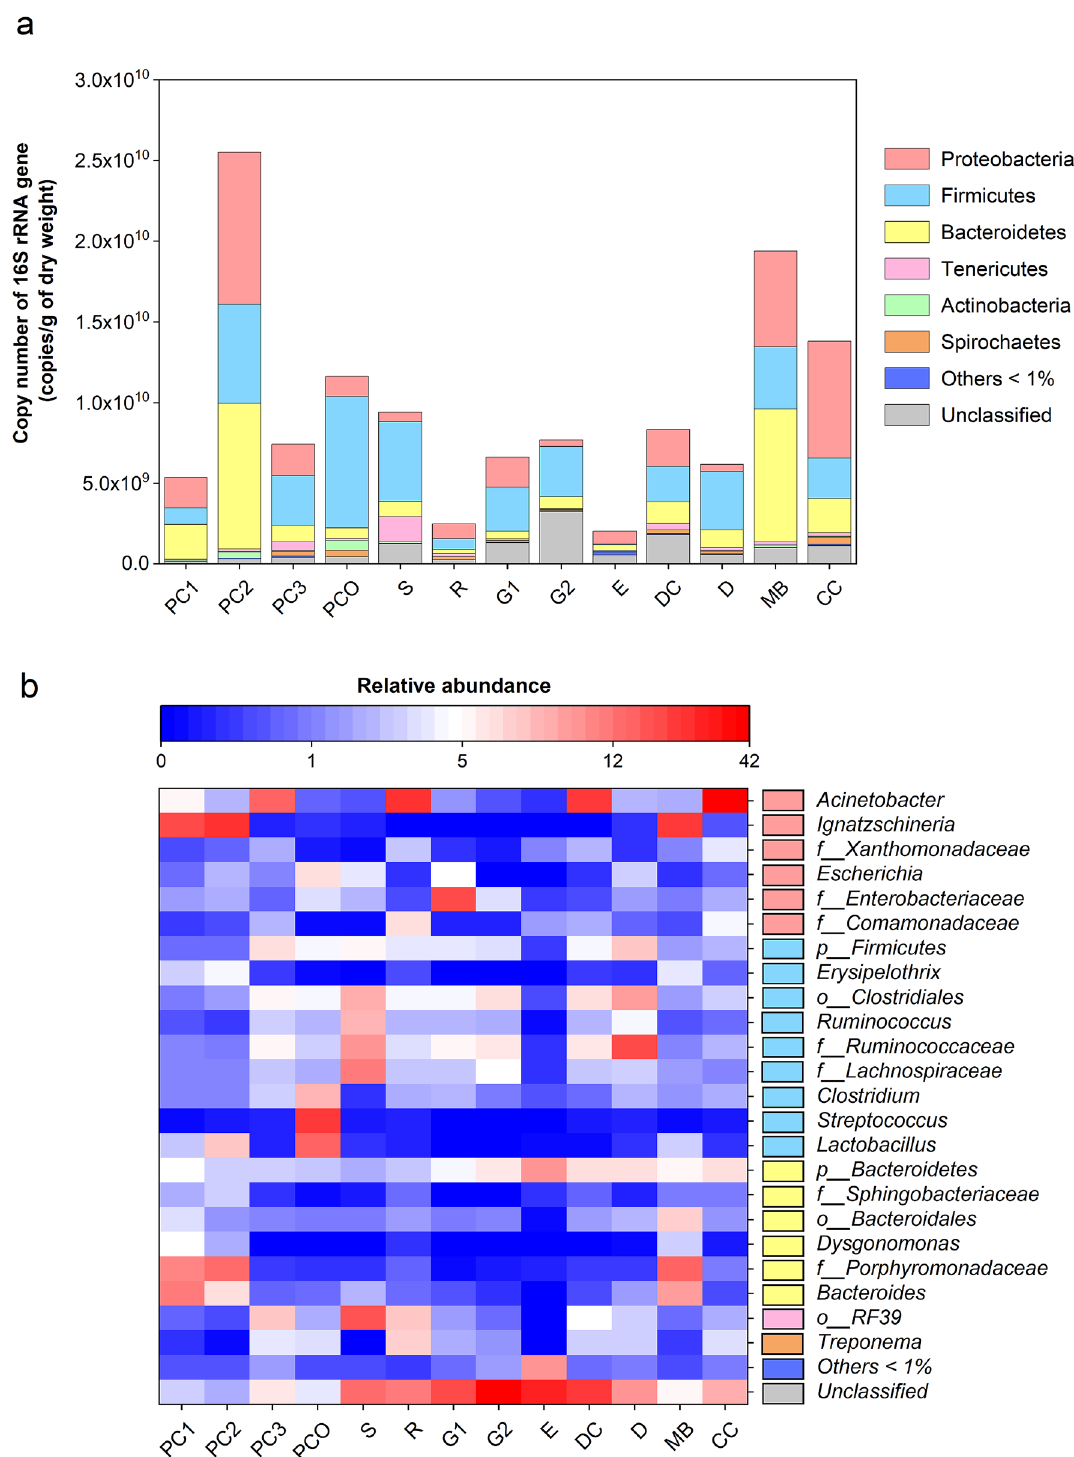
Figure 3. Analyses of bacterial community structures by ( a ) copy number of each phylum and ( b ) percent abundance of each genus (heatmap showed only genera with > 1% abundance). In ( b ), the OTUs where Mothur could not identify the genus name were denoted by small letters ( p_ abbreviates phylum; o_ , order; and f_ , family) to the deepest taxonomic names that could be